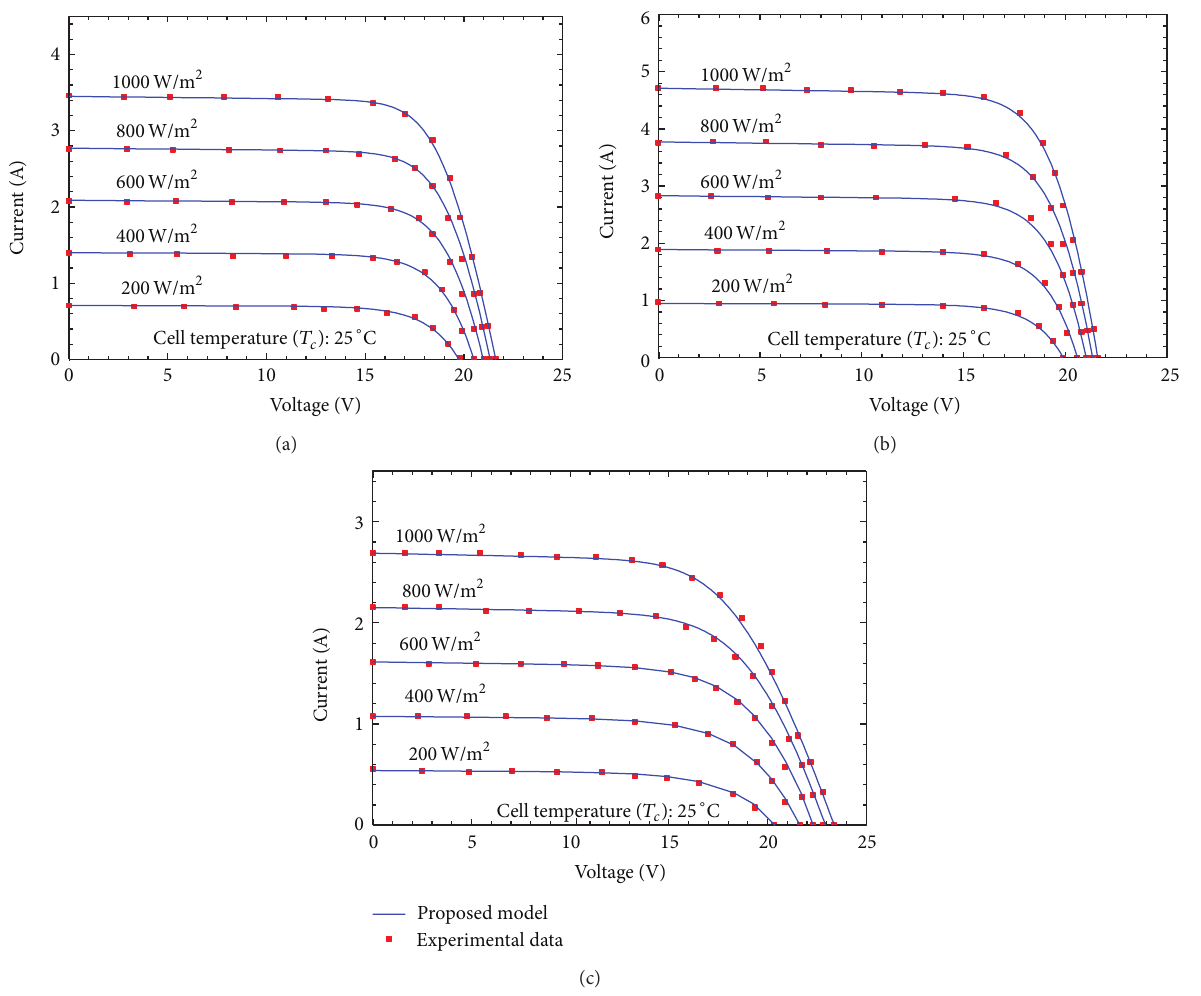
Figure 3: Calculated I - V curves and experimental data of Shell SM55 (a), Shell S75 (b), and Shell ST40 (c) at different irradiance, at 25 ∘ C.